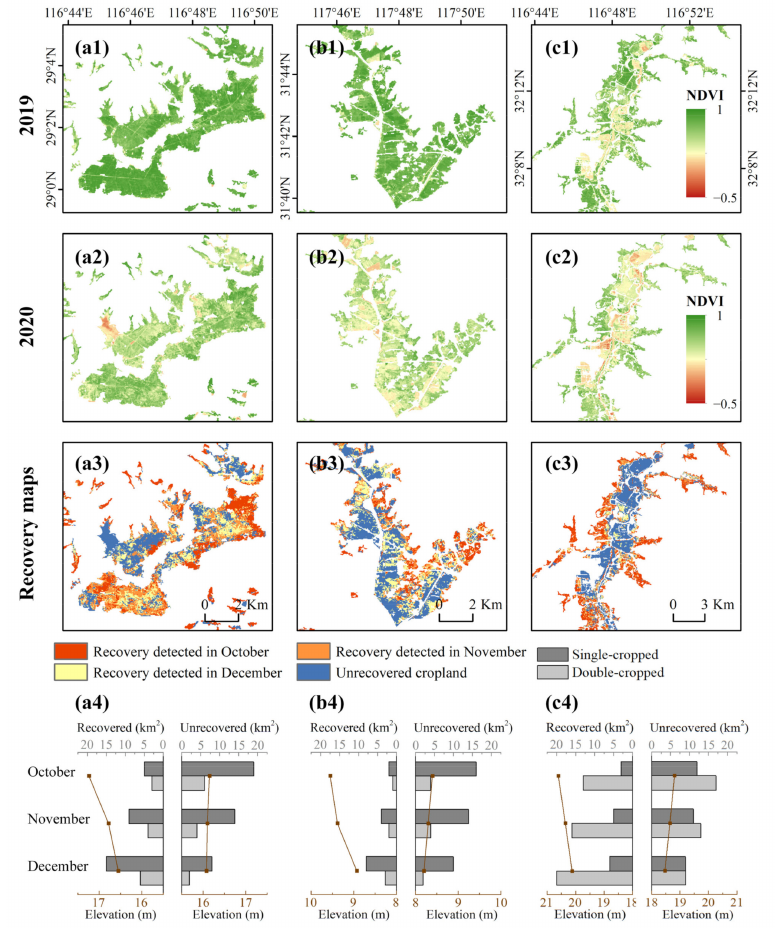
Figure 13. Local details of the classification results. The maximum NDVI composite from mid- September to December in 2019 and 2020, the zoom-in agricultural recovery map and local character- istics of recovered and unrecovered croplands in the east of the Poyang Lake ( a1 – a4 ), northeast of the Chao Lake ( b1 – b4 ) and south of the Huai River ( c1 – c4 ).